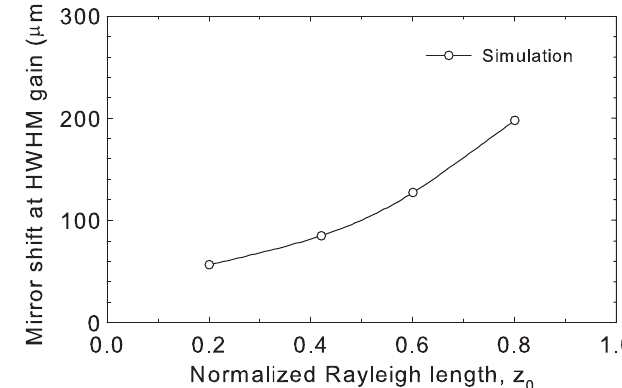
FIG. 5. Simulations of gain vs normalized mirror tilt angle for ¼ 0 : 42 . The angle at half-width half-maximum (HWHM) z 0 gain and the maximum angle in (cid:4) rad are shown.